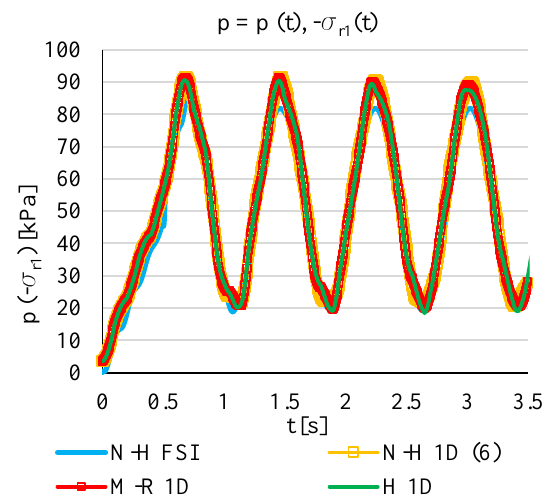
Fig. 20. Static pressures p in thick-walled tube.